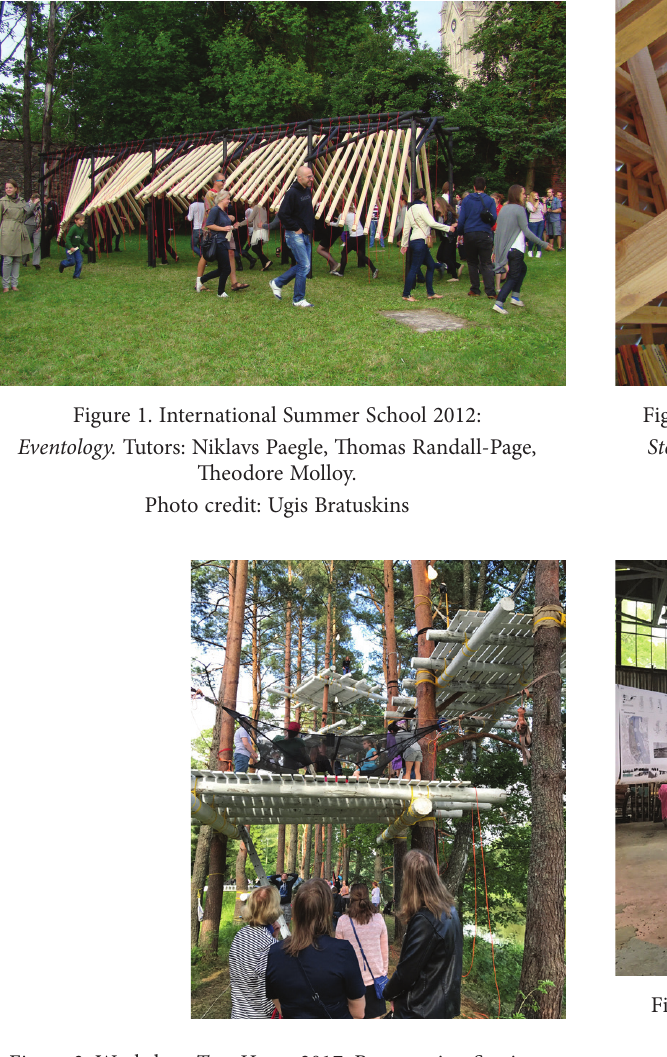
Figure 3. Workshop Tree House 2017. Presentation Session.